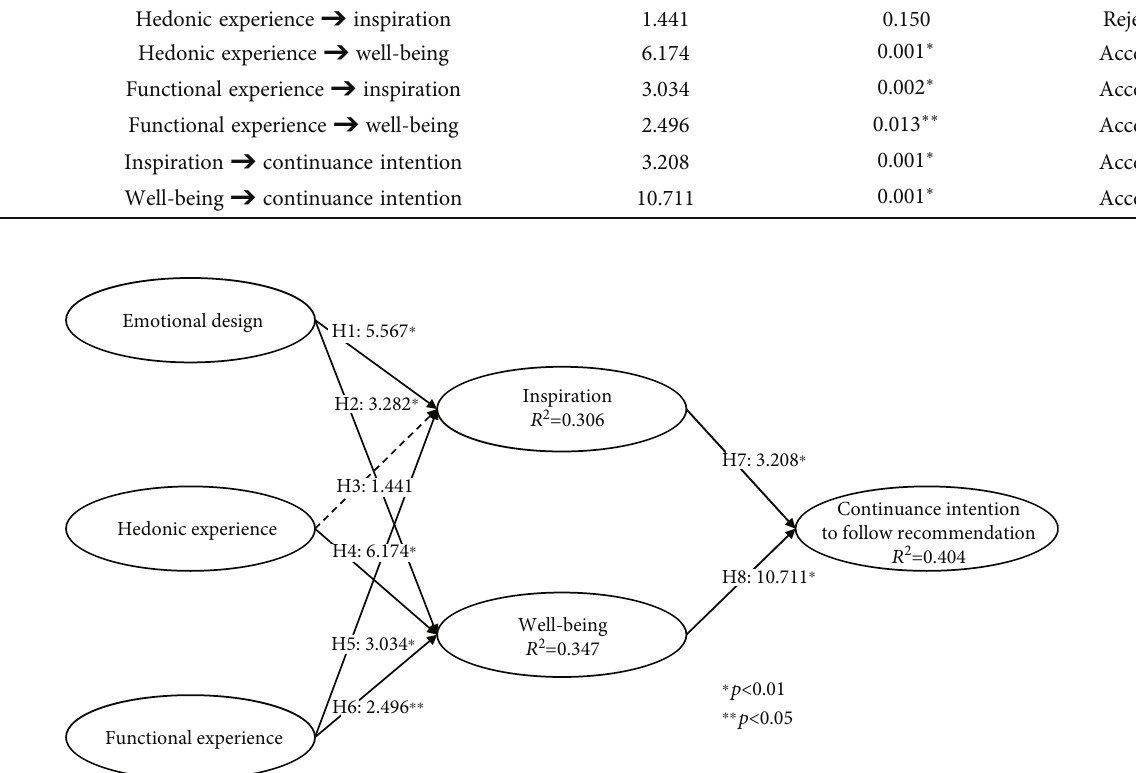
Figure 2: Proposed model